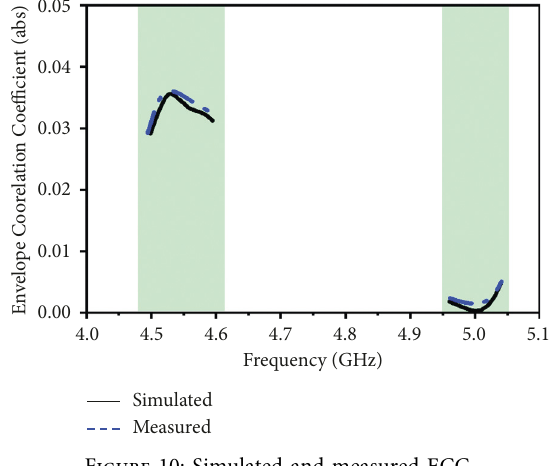
10: Simulated and measured